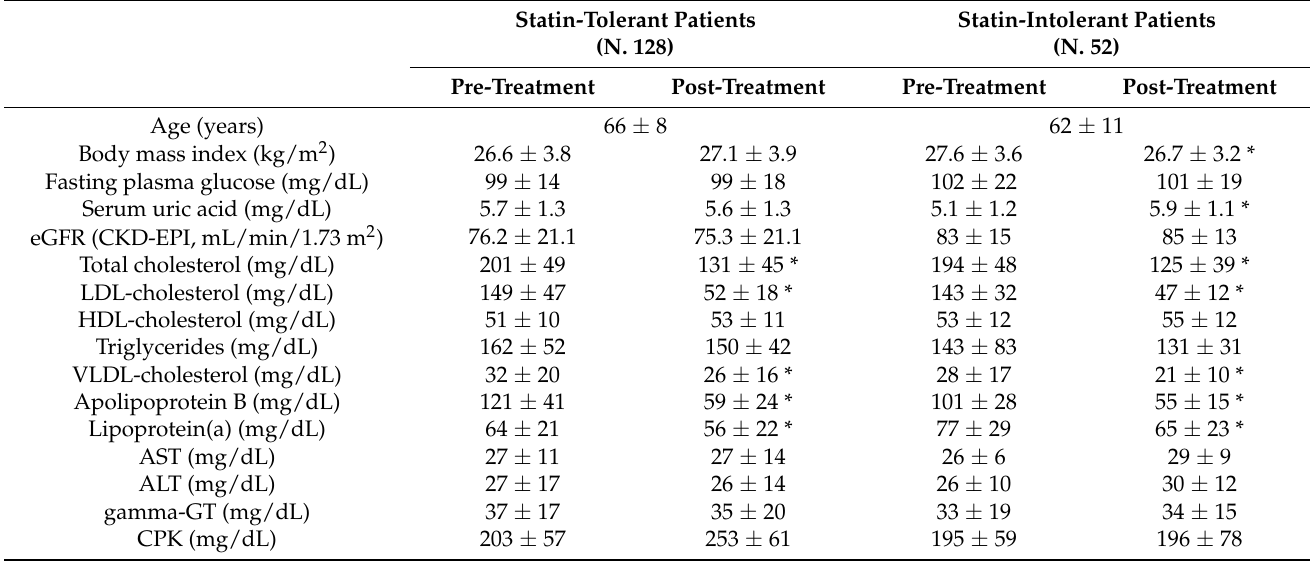
Table 3. Effect of 6-month treatment with PCKS9 inhibitors in statin-tolerant and statin-intolerant patients. Statin-Tolerant